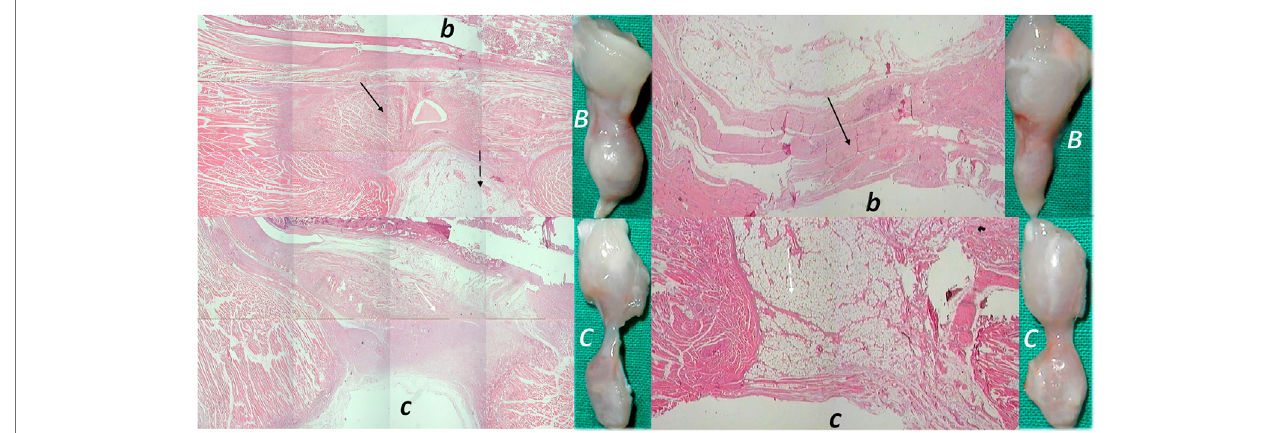
FIGURE 9 | (Left , 14 days) (right , 28 days). Transected muscle and BPC 157 therapy (Staresinic et al., 2006). Quadriceps muscle was completely transected transversely1.0 cmproximaltothepatellameansade fi nitivedefect thatcannotbecompensatedinrat.BPC157(10 μ g,10 ng, and10 pg/kg)isgivenintraperitoneally, once daily; the fi rst application 30 min posttransection, the fi nal 24 h before sacri fi ce. Throughout the whole 72-day period, BPC 157 consistently improves all muscle- healing parameters (biomechanic, function, macro/microscopy/immunochemistry, fi nally presentation close to normal non-injured muscle, and no postsurgery leg contracture). Controls exhibit stumps grossly weakly connected ( C ), at postsurgery day 14 and 28, microscopically (HE, x10), at postsurgery day 14, gap fi lled with fi brous tissue (white arrow) ( c ), and at postsurgery day 28, a gap fi lled with fat tissue(dashed whitearrow); incorporating few collagen strands is interposed between the transection stumps and unsuccessful attempts of muscle fi bers to cross the gap can be observed ( c ). Contrarily, BPC 157 rats exhibit stumps grossly well connected, approaching to presentation of the normal non-injured muscle ( B ), microscopically, at postsurgery day 14 and at postsurgery day 28, broad muscle (black arrow) fi bers connecting the stumps, while the fat tissue is much less present ( b ) (dashed black arrow).